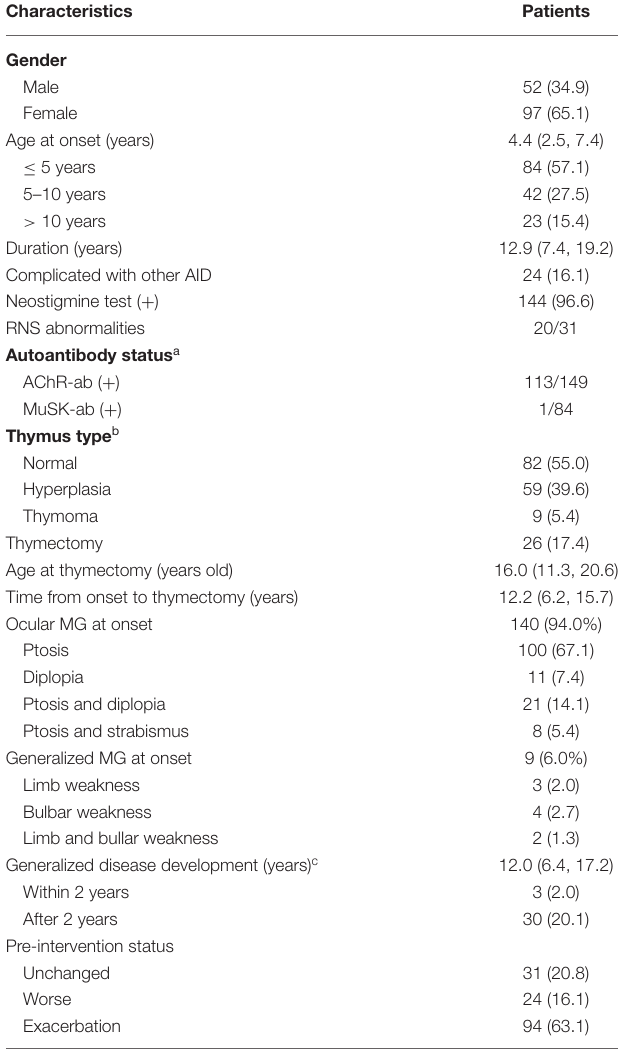
TABLE 1 | Baseline characteristics of 149 study